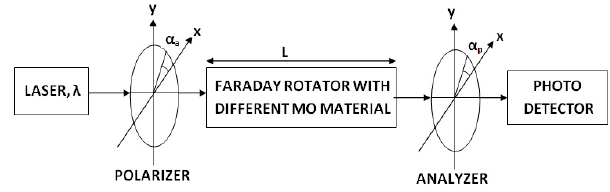
Figure 1. Schematic diagram of the basic magneto-optic measure- ment